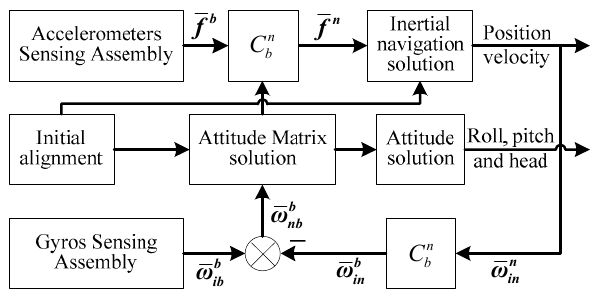
Figure 1. The operational principle of SINS (strapdown inertial navigation systems).